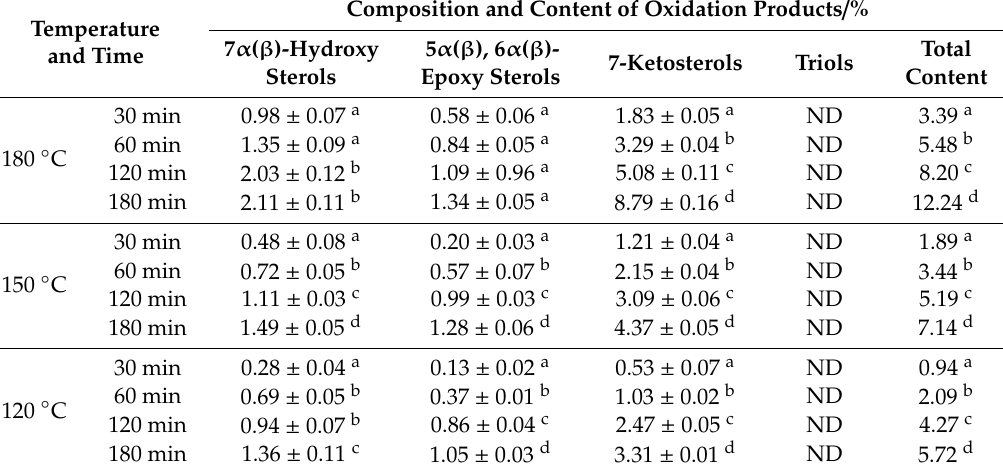
Table 3. The total content and composition of SGPs’ oxidation products in olive oil *. Temperature and Time